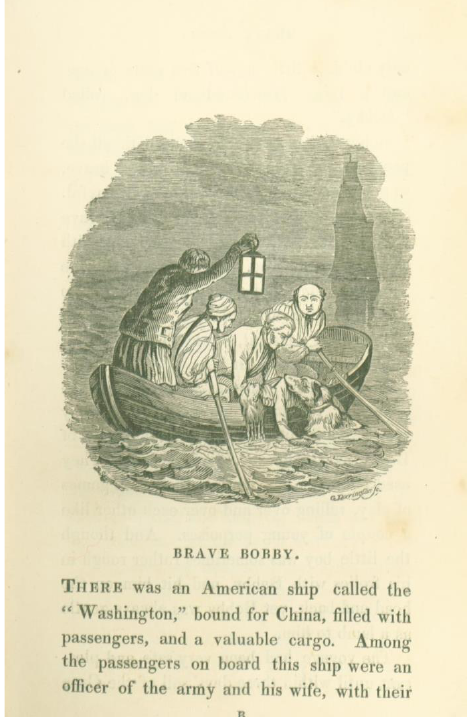
Fig. 2 Spread from The Vocal Library (London: Mason, n.d.), pp. 3–4, showing Seymour’s first contribution to the volume. The Vocal Library was put together as a serialised reprinting of the Cabinet Songster (1833) which was itself a compendium of material first published in a periodical called the Casket in 1832 under the weekly banner of the Casket Songster .